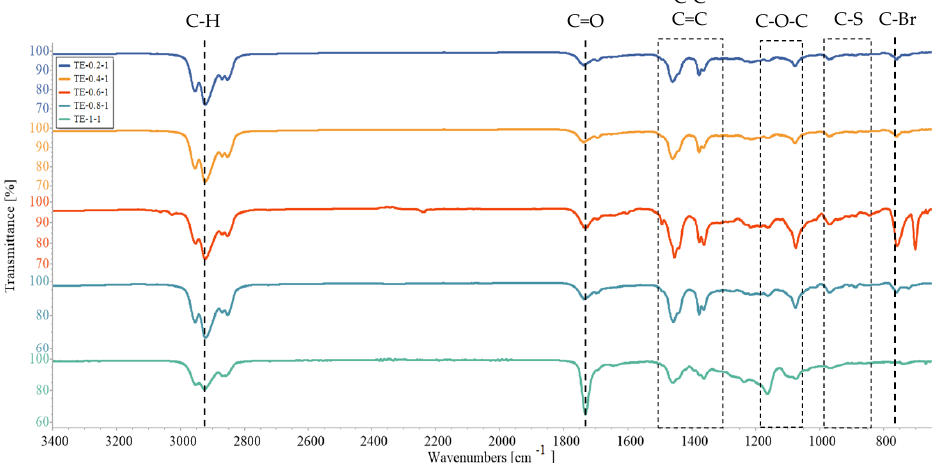
Figure 6. PEDOT ATRP macroinitiator FTIR spectrogram for ThBr:EDOT ratios 1:0.2; 1:0.4; 1:0.6; 1:0.8, and 1:1.